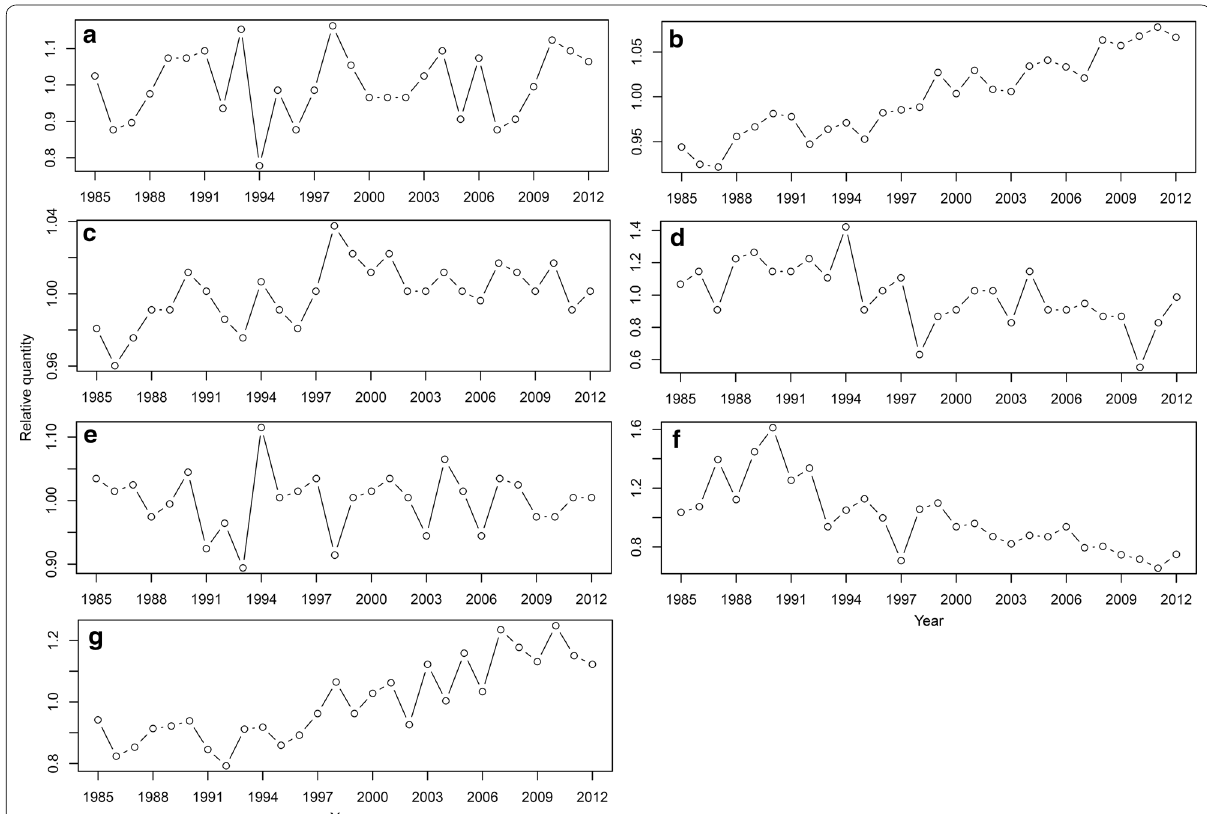
Fig. 1 Temporal variation of the environmental factors in Japan from 1985 to 2012. a Rainfall. b Sea water CO 2 concentration. c Sea surface temperature. d Number of typhoon. e Solar radiation. f Sea water nutrient level. g Sea water quality. The value in each year was transferred to the ratio of the mean value among the 28 years for each environmental factor. See “Methods” for